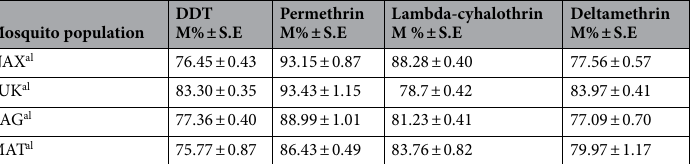
DNA sequence analysis. An amplified 350 bp fragments (Supplementary Fig. 1) of IIIS6 vgsc gene were